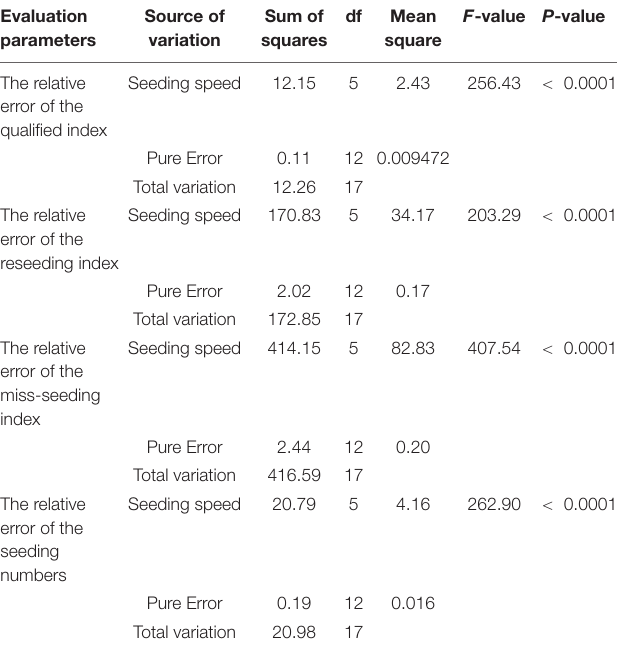
TABLE 5 | Analysis of the seeding speed variance based on the evaluation parameters. Evaluation Source of parameters